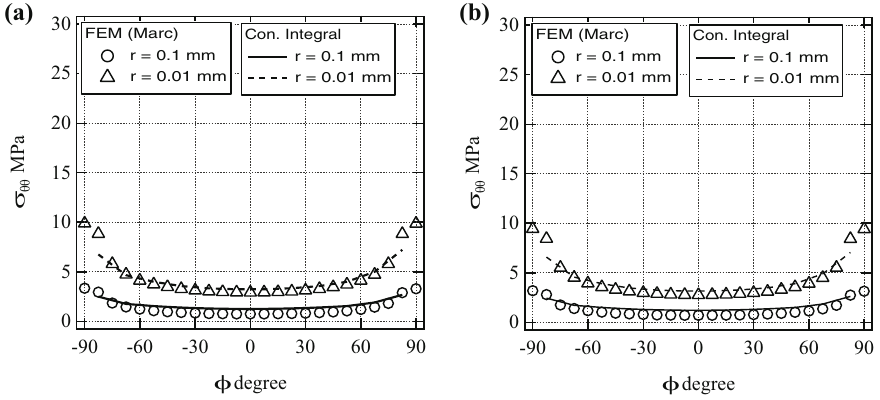
Figure 12: Distribution of stresses, σ θθ , at the interface, = θ 90° , with fi xed r at 0.01 and 0.1 mm on the singular line ( front - line at d = 3 mm ) : ( a ) Model - 1 and ( b ) Model - 2.